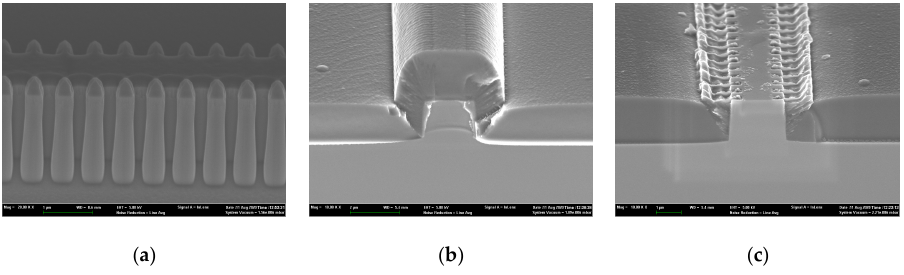
Figure 2. ( a ) SEM image of the as-etched waveguide and lateral gratings. ( b ) Surface topography of the SiO 2 supporting layer. ( c ) SEM image of the waveguide and lateral gratings after removing SiO 2 on top of the current injection region.